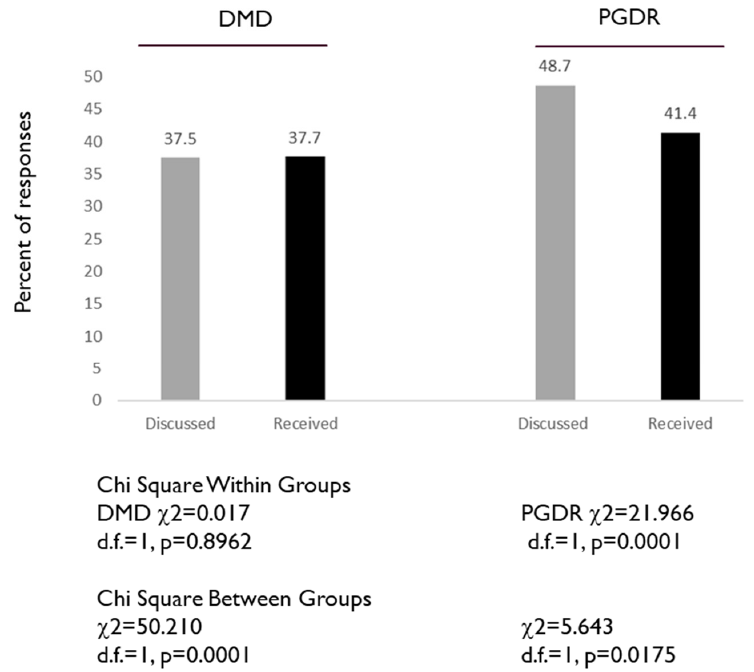
Figure 3. Assessment of DMD and PGDR responses to specific HPV-related questions: I have discussed HPV vaccination with a doctor, and I have received the HPV vaccination. DMD students exhibited similar percentages of having discussed HPV vaccination (37.5%) and having received HPV vaccination (37.7%), while PGDR exhibited higher percentages of having discussed HPV vaccination (48.7%) and having received the HPV vaccine (41.4%) p = 0.0001.